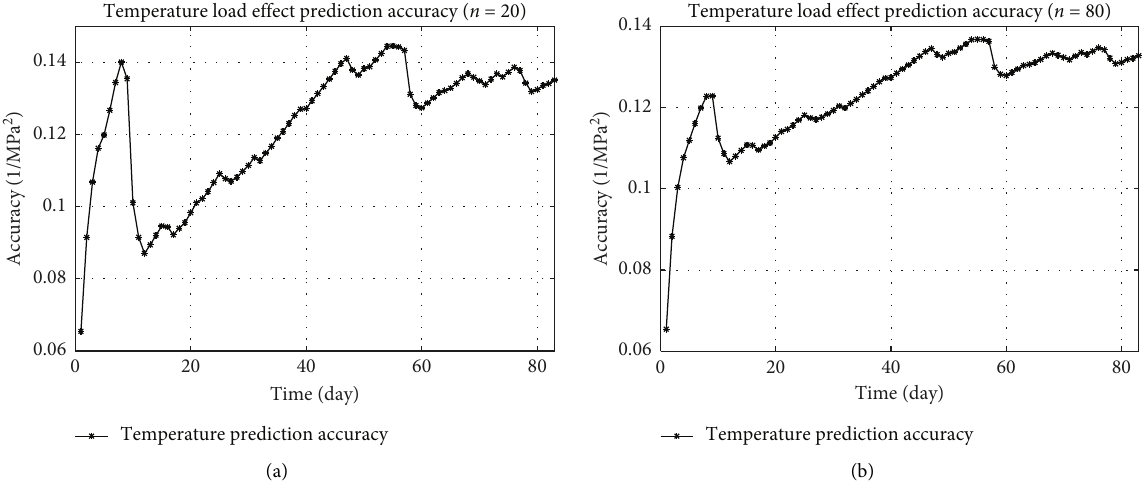
Figure 8: The curve of prediction accuracy with the different parameter n